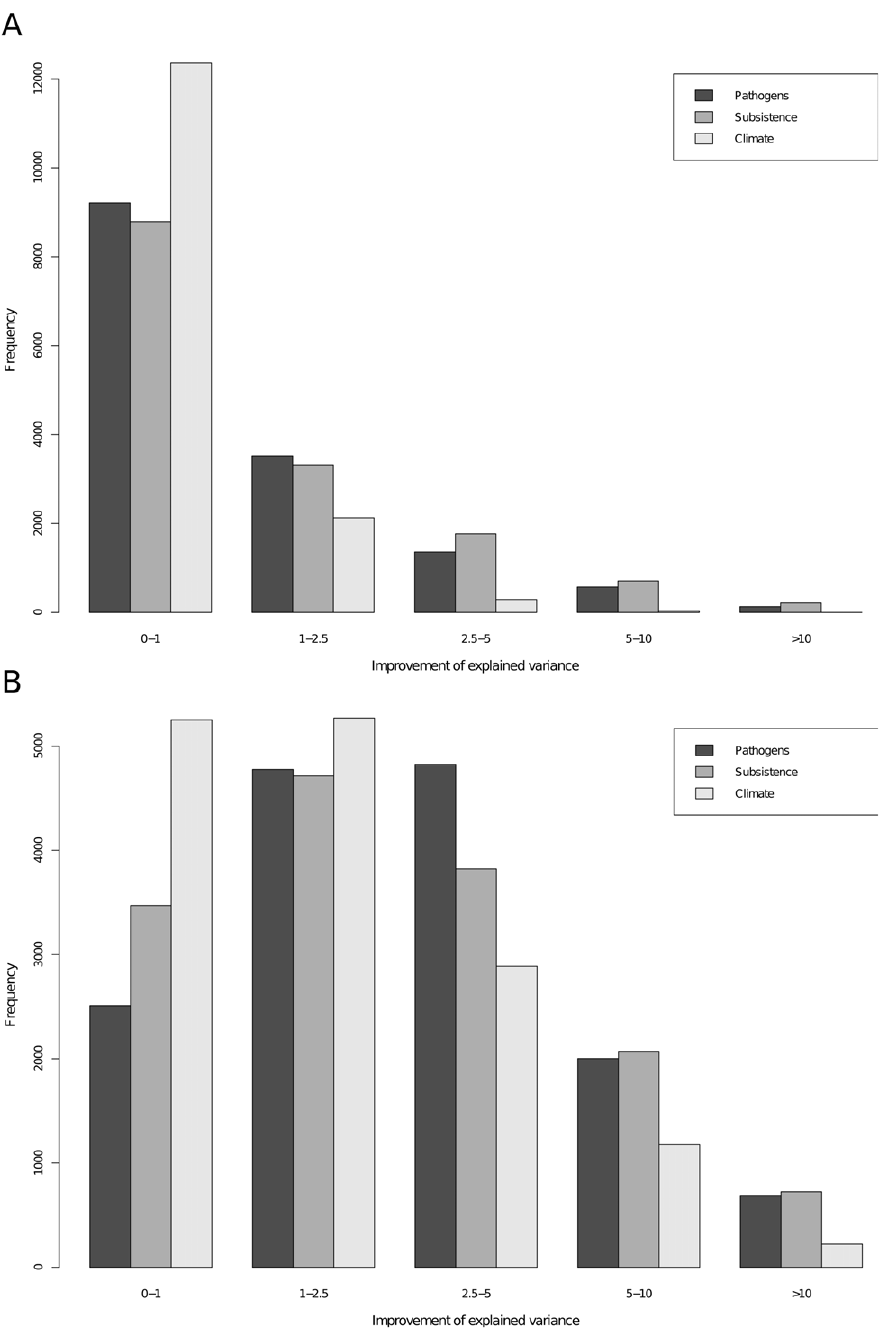
Figure 3. Frequencies of genes. Frequencies of genes displaying different values of improvement of explained variance with three distinct models, comprising only pathogen diversity, subsistence strategies and climate conditions, separately (A); and when testing each variable separately and taking the maximum value within each environmental category (B).